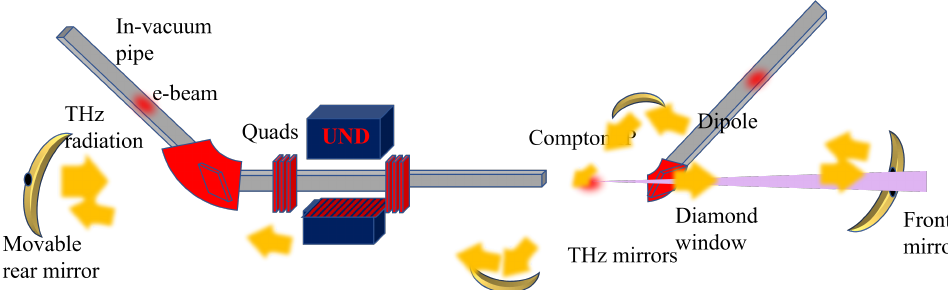
Figure 1. Dual source of THz and X-ray radiation. The cavity is constituted by four mirrors, one of them holed or translucent. The Compton interaction point is on the right, and the focusing is realised by the mirrors themselves. Electron beam and THz radiation interact at